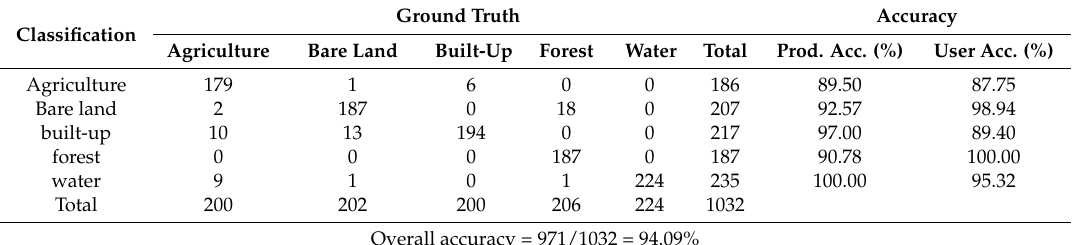
Table 5. Error matrix of the traditional supervised classification